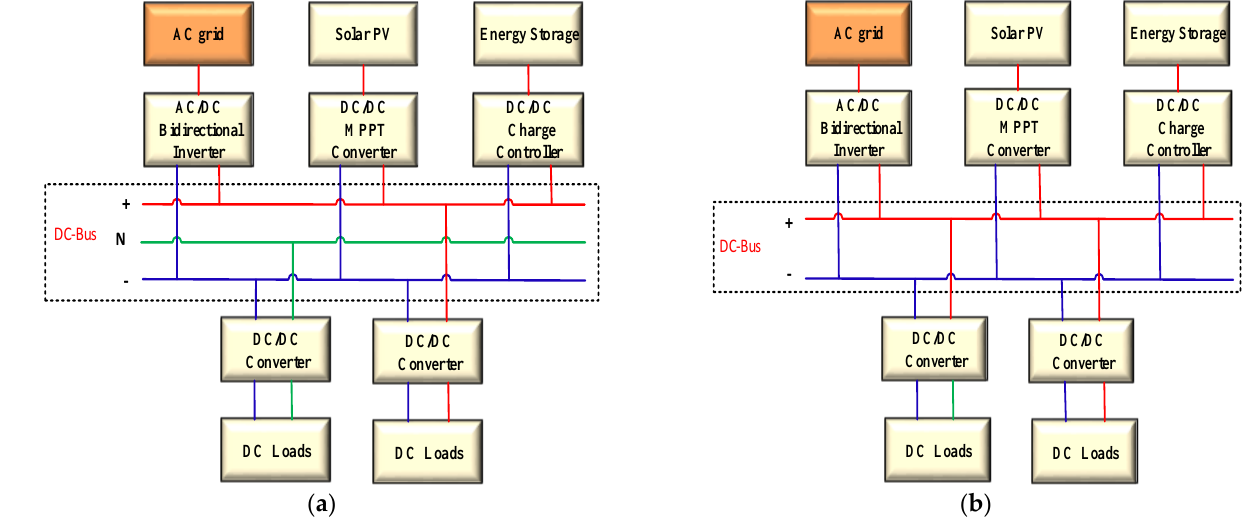
Figure 2. The structure of ( a ) bipolar DC bus, ( b ) unipolar DC bus. A comparison of the existing empirical literature on DC-bus voltage versus power integrated with a single-phase bidirectional inverter is illustrated in Figure 3. Based on the results, it may be observed that once the power level is high, the voltage typically corresponds to that of the peak mains, i.e., √2 times the root mean square (rms) voltage. It 380 to 400 V. High-voltage operation (i.e., 600 V) is applied in cases where two voltage levels (600 V/300 V) may be required, allowing for the adaptability of DC load connection.